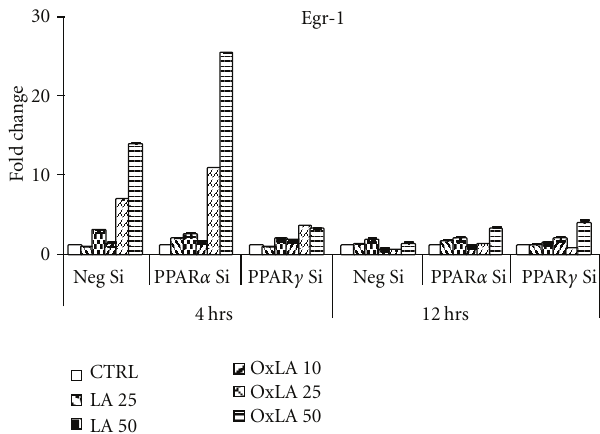
Figure 4: Downregulation of PPARs by siRNA alters ω -6 lipid- mediated induction of Egr-1 mRNA: RASMCs were transfected with SMART-pool siRNA duplexes of PPAR α , PPAR γ or nontar- geting control siRNA, followed by treatment with ω -6 lipids for 4 and 12hrs. Preliminary findings indicated Egr-1 mRNA levels were upregulated when PPAR α was knocked down compared to PPAR γ knockdown as determined by qRT-PCR. The fold change was calculated by comparing lipid treatments with vehicle controls in each siRNA group. All values were normalized to β -actin (house- keeping gene). mRNA levels were expressed as fold change ± SEM (Standard error of Δ CT